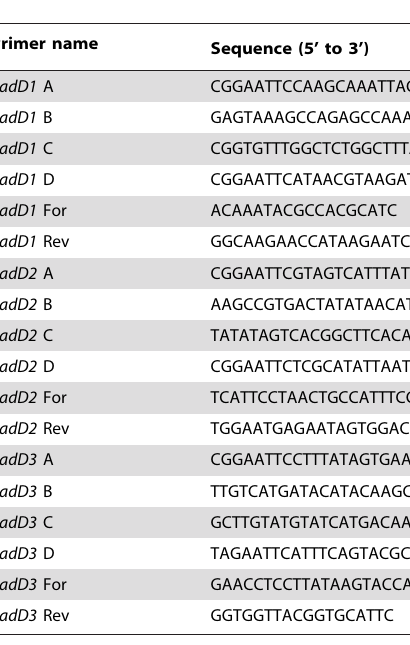
Table 2. Primers used in this